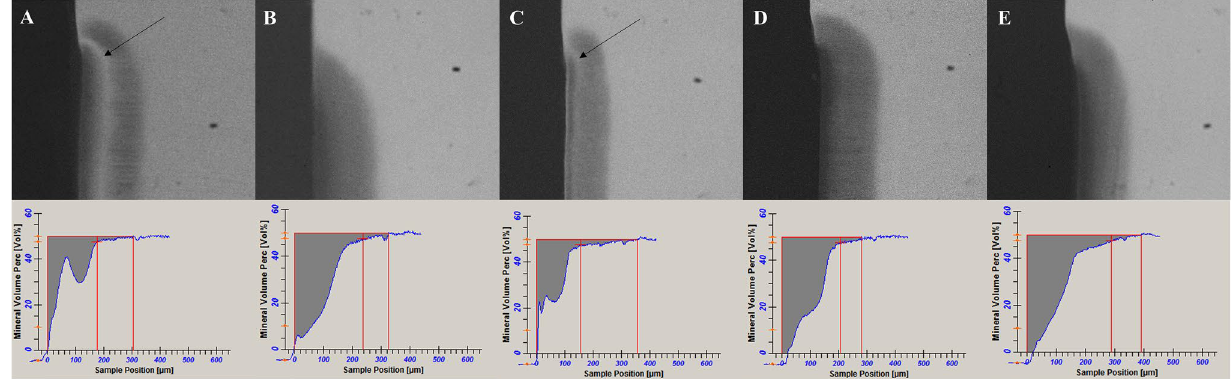
Figure 1. Representative TMR image and lesion profile of a dentin sample from each of the following groups: ( A )